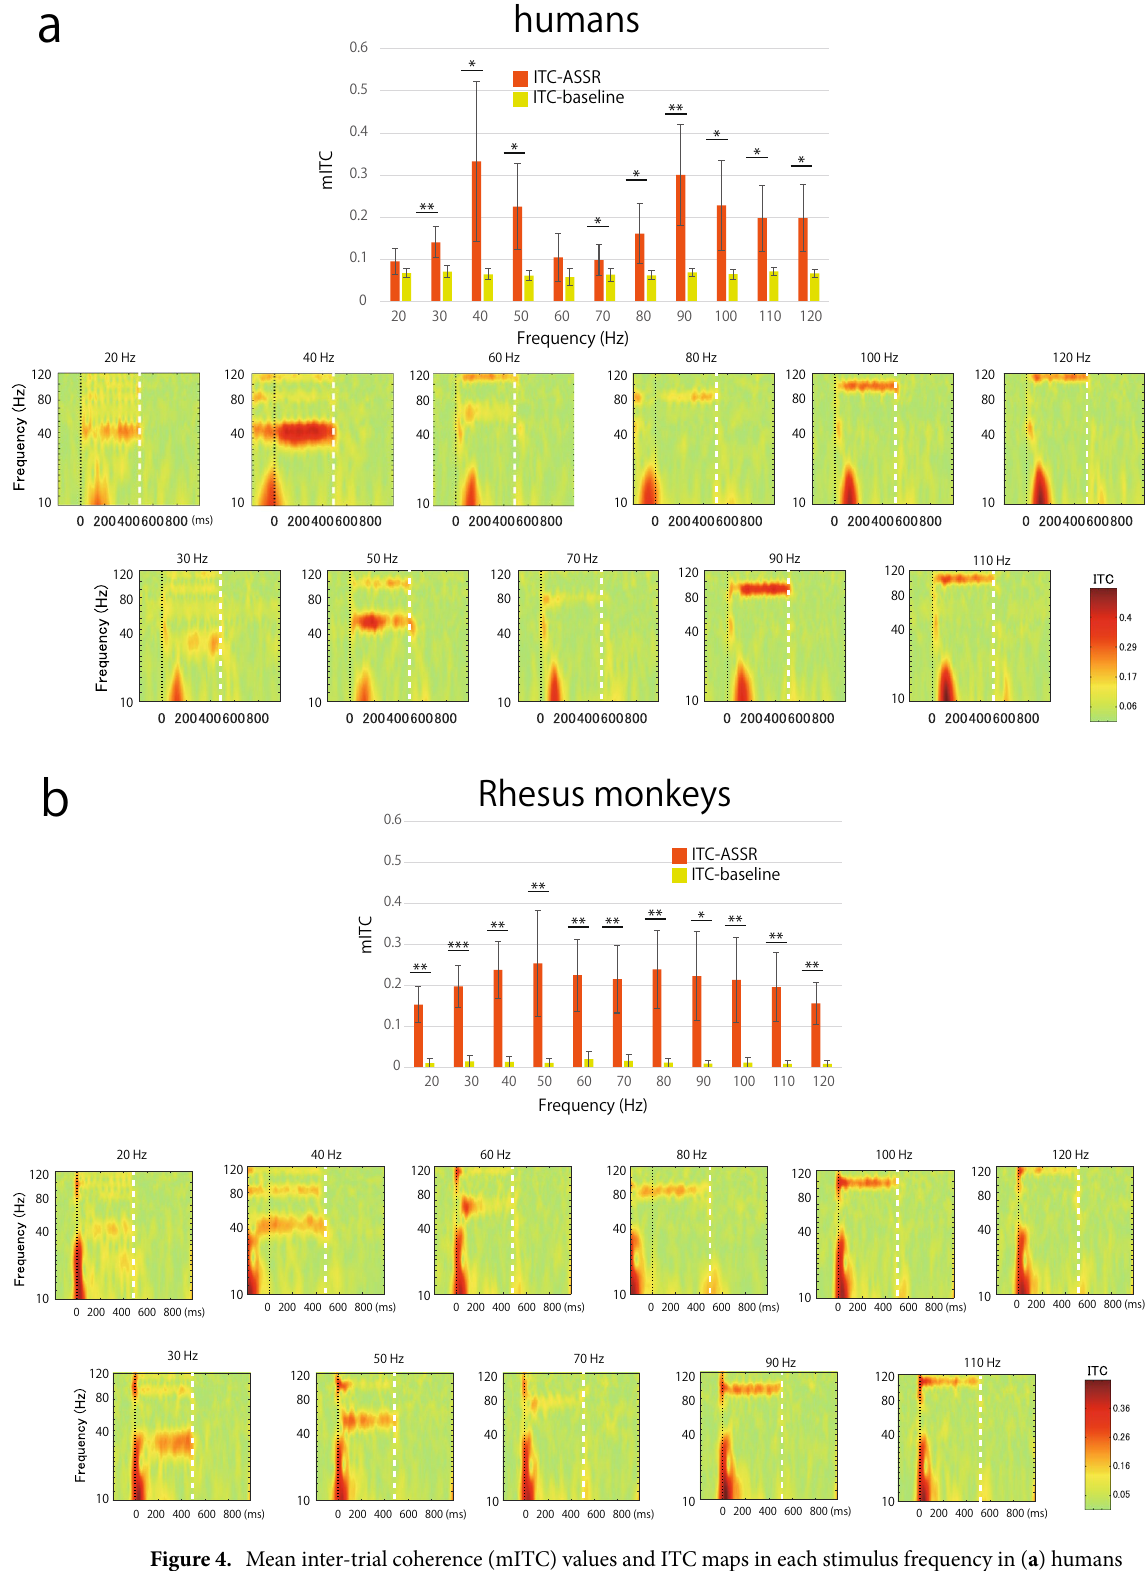
Figure 4. Mean inter-trial coherence (mITC) values and ITC maps in each stimulus frequency in ( a ) humans ( b ) rhesus monkeys, and ( c ) marmosets (n = 5). All data were recorded from the Cz electrode. (Upper panel) Orange bars indicate the mean ITC values (mITCs) during train presentation (ITC-ASSR), and yellow-green bars indicate those during baseline (ITC-baseline) in each stimulus frequency. Horizontal lines and asterisks indicating significant differences between ASSR and baseline (* p < 0.05;** p < 0.01; *** p < 0.001). Error bars indicate the standard deviations of the mean. (Lower panel) Averaged ITC maps in each stimulus frequency (n = 5). The vertical line of time 0 indicates the beginning of the stimulus, and the vertical white line (on time 500 ms) indicates the end of the